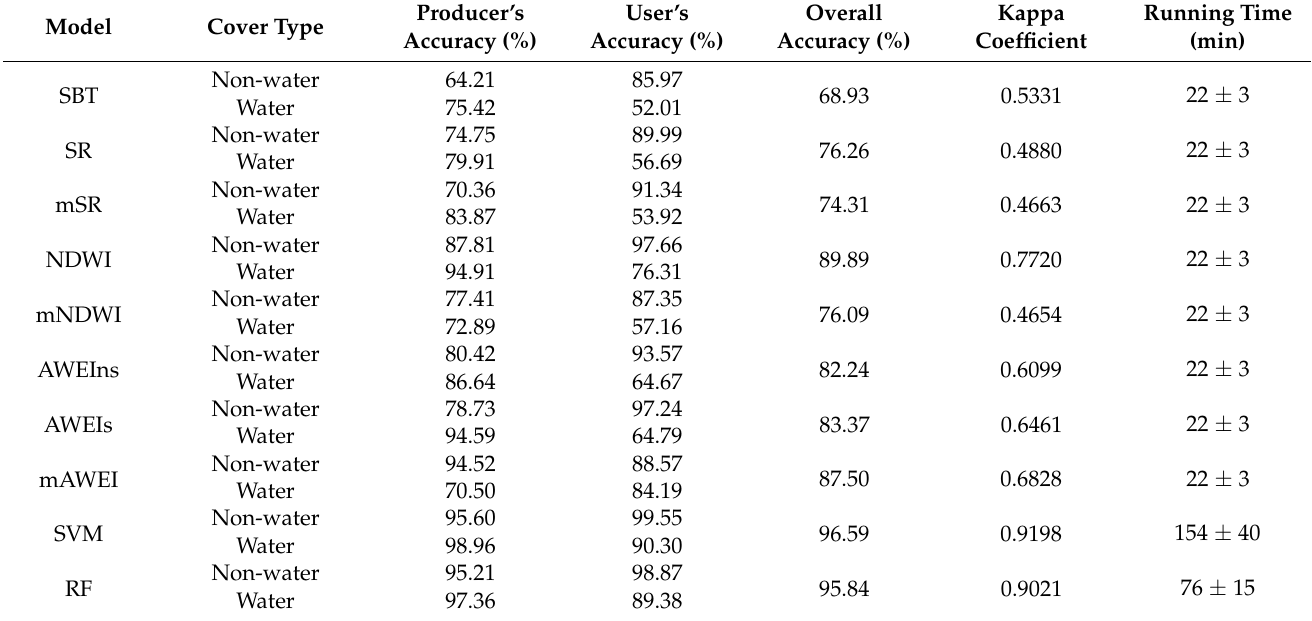
Table 3. Accuracy and running time of waterbody extraction with different